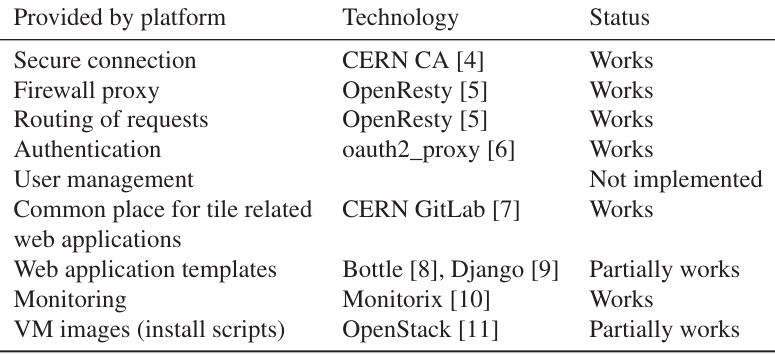
Table 1. Rundown of technologies used in the new Tile-in-One.